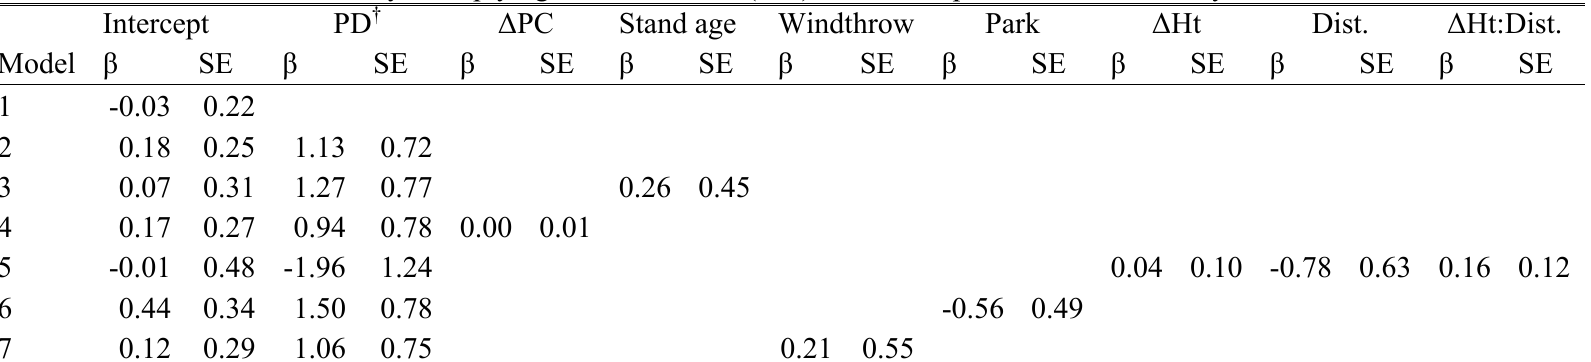
Table A2.1 Parameter estimates for models examining variation in stand-level trends (between circa 1994 and 2014) in abundance Red-eyed Vireo in aspen dominated mixedwood forests in central Saskatchewan. 85% Confidence Intervals can be obtained as β ± 1.44* SE. NOTE: Parameter values were rescaled by multiplying with a constant (100) for ease of presentation, divide by 100 to obtain